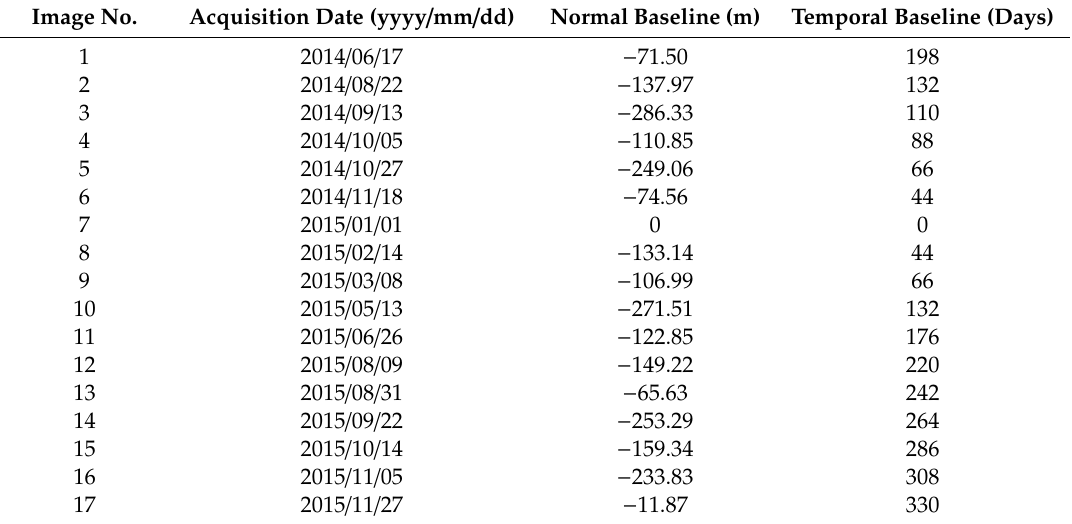
Table 2. List of the interferometric pairs and their parameters with image number 7 as the master (orbit no. 119,